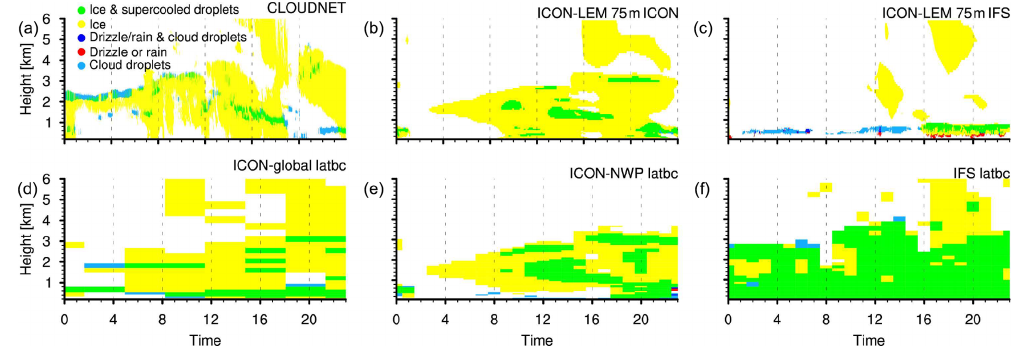
Figure 4. Classification for the case study of 23 June 2017 showing the observations (a) the ICON-LEM results at 75m resolution with forcing from the ICON family (b) and the ICON-LEM results at 75m resolution with forcing from the IFS (c) . The respective forcing data for the lateral boundary conditions (latbc) from the ICON global model (ICON-global; d ), the ICON at 2km resolution (ICON-NWP; e ) and the IFS (f) are also shown.